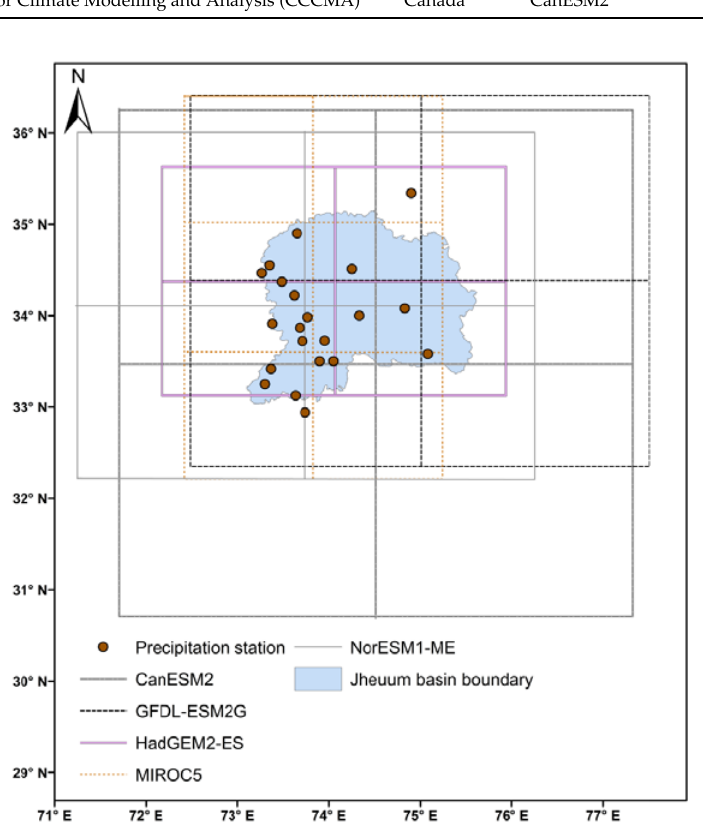
Figure 2. GCM grids coving the Jhelum River basin .